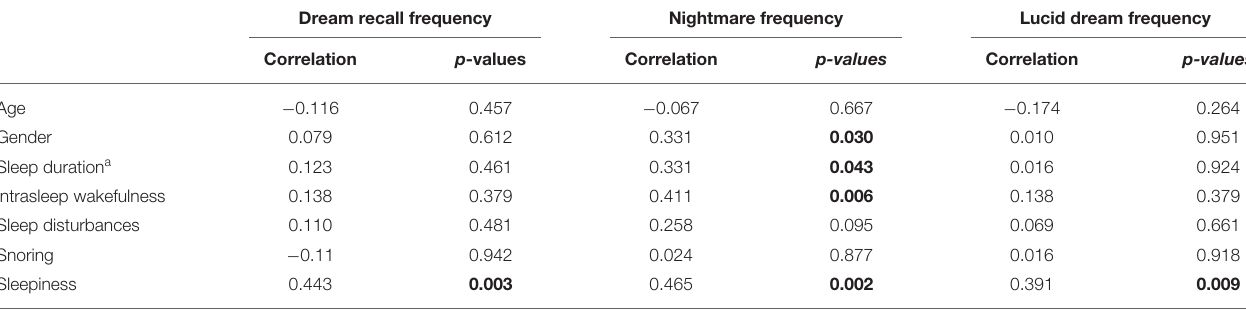
TABLE 3 | Features related to dream frequency in narcoleptic patients: Spearman’s correlation coefficients.